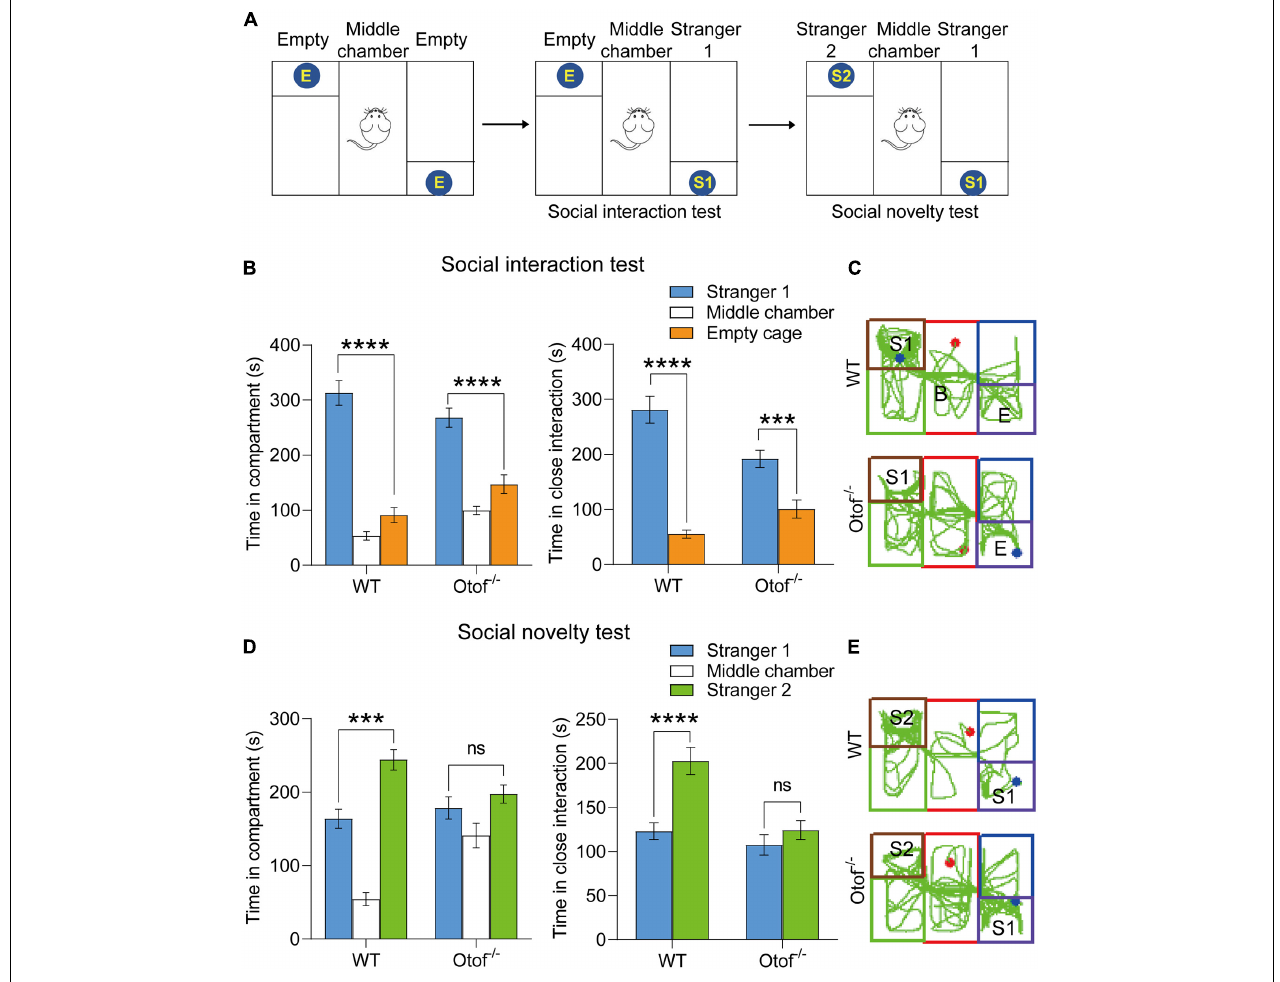
FIGURE 2 | Otof − / − mice showed impaired social memory in a three-chamber social interaction experiment at 2 months old. (A) The schematic diagram of a three-chamber social interaction experiment. (B) Both WT and Otof − / − mice showed normal sociability in the social interaction test: the subject mouse spent more time interacting with stranger 1 (S1) than the empty wire cage E. (C) Representative tracks of WT and Otof − / − mice in the social interaction test. (D) Otof − / − mice showed impaired social memory in the social novelty test compared with WT mice. (E) Representative tracks of WT and Otof − / − mice in the social novelty test. The starting point and the ending point of tracks in (C,E) were represented by a red dot and a green dot, respectively. All values are presented as mean ± SEM and analyzed by unpaired t -test for (B) and (D) . *** p < 0.001, **** p < 0.0001 vs. WT. WT: n = 20; Otof − / − : n = 21. WT, wild-type mice; Otof − / − , otoferlin knockout mice; E, empty; S1, stranger 1; S2, stranger 2; ns, not